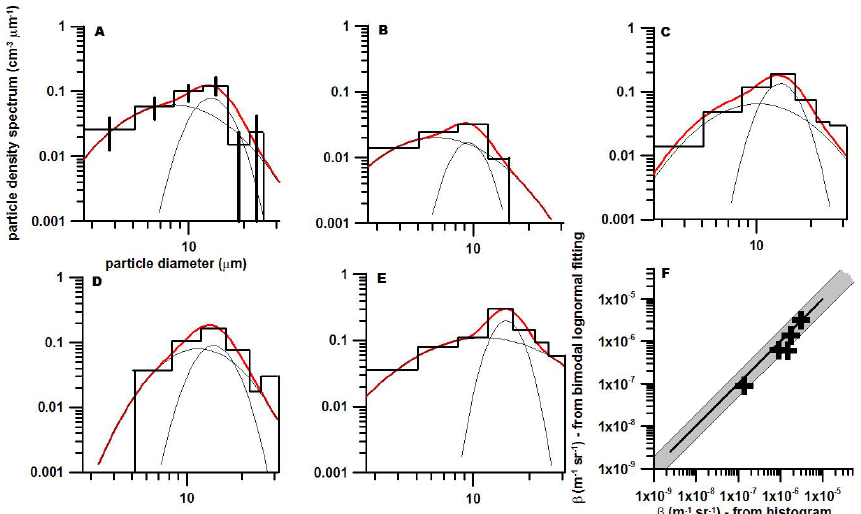
Fig. 2. Panels (A) through (E) show the histograms of the measured size distribution (black lines) with their error bars (shown only in panel (A) for sake of clarity) and their bimodal lognormal fitting functions (red lines). Thin black lines show the two monomodal contributing to the bimodal. In panel (F) a scatterplot of backscattering coefficient computed from the histograms – horizontal axis – and from their respective bimodal lognormal fits – vertical axis – is displayed. A grey band marks the region where the mismatch stays below a factor 2.